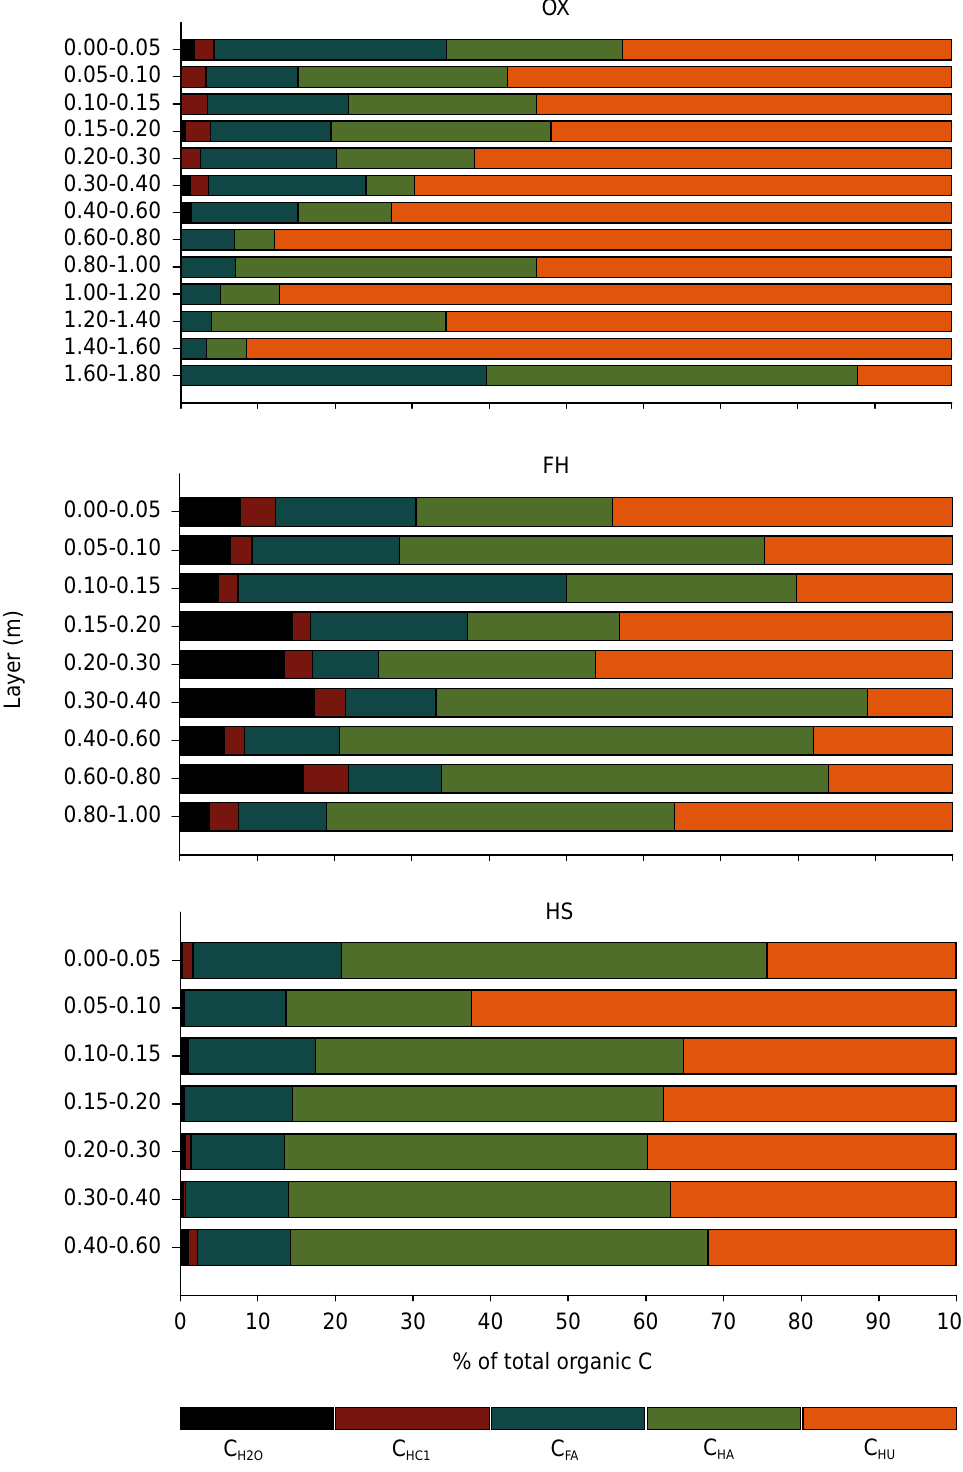
Considering all soils, the highest C portion in the non-humic fraction was observed in the water extract (3.4 %), whereas in the HCl extract, the proportion was only 1.9 % of the total organic C. These fractions are composed of more labile hydrophilic structures, which are smaller than the FA and HA structures. These organic compounds are soluble in water and acid extract and are derived from microbial activity, as well as root exudates (Potes et al., 2010). The higher solubility of these compounds